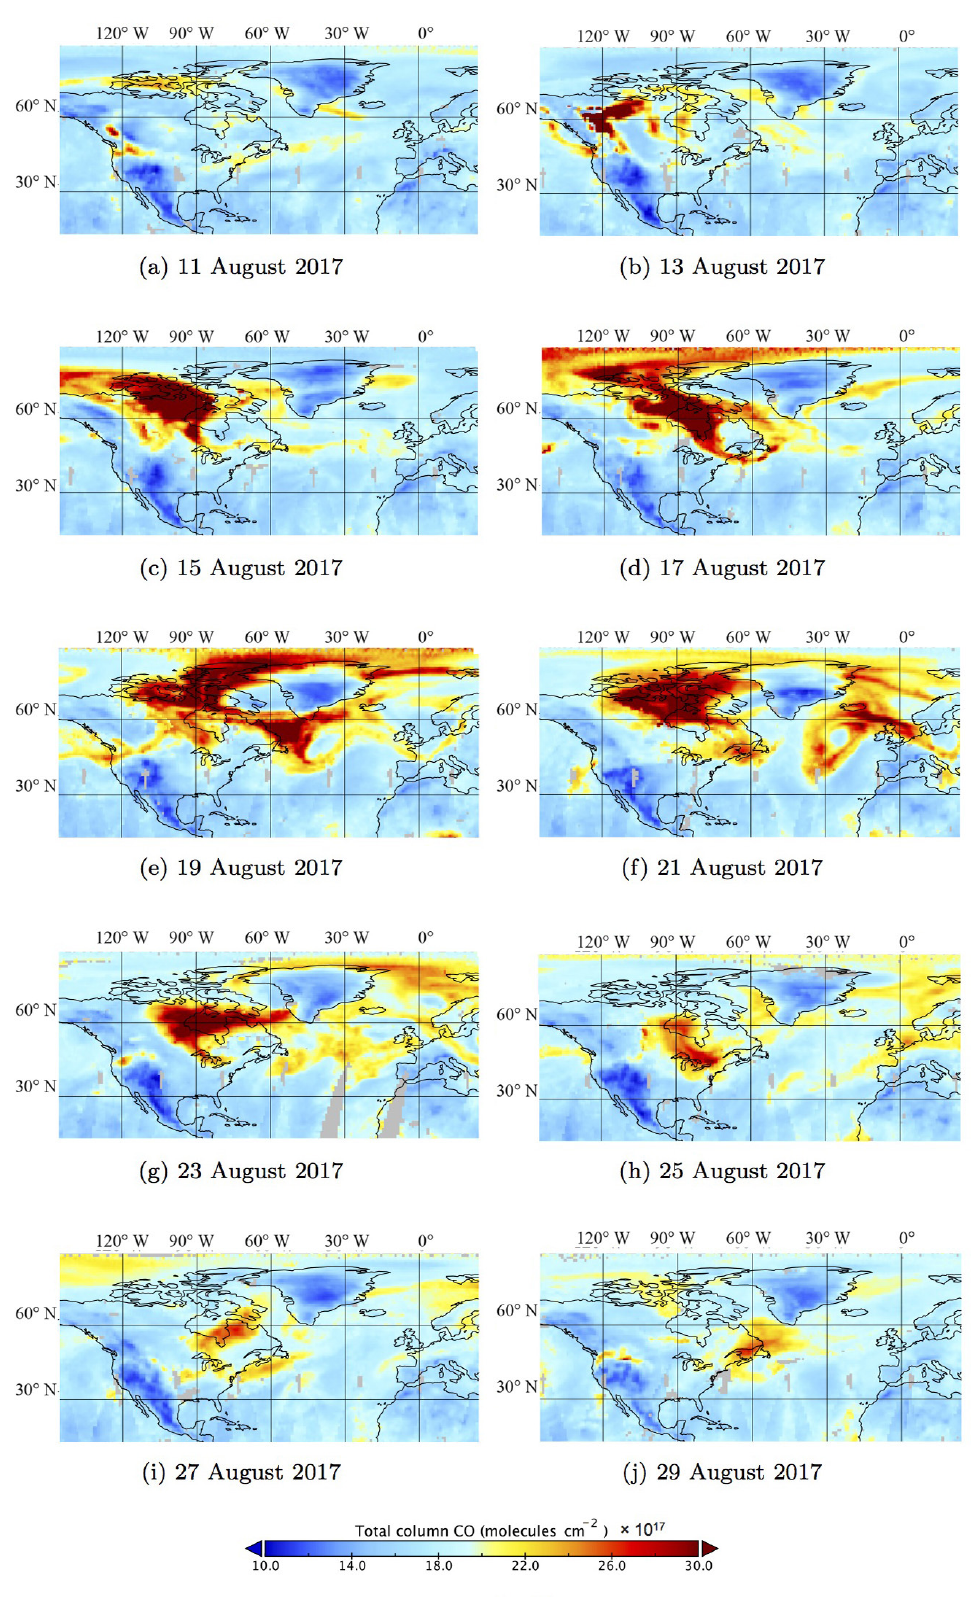
Figure 6. Total CO concentration (moleculescm − 2 ) retrieved from AIRS. The maps are plotted every 2 days from 11 to 29 August 2017.